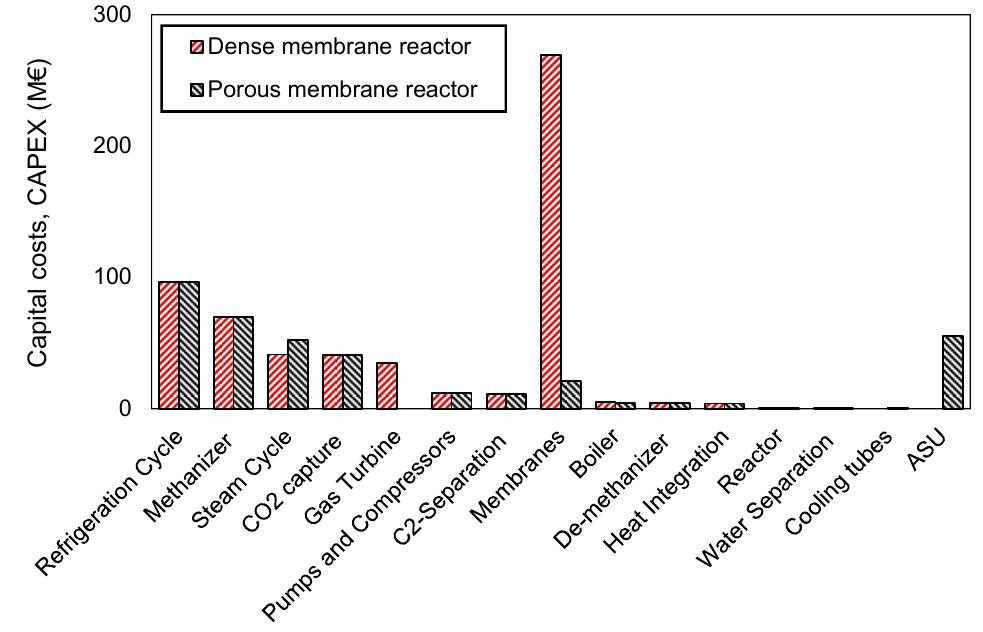
Figure 4. Disaggregated capital costs (BEC), CAPEX (Capital costs), for the OCM plant employing a dense membrane reactor (red) and a porous membrane reactor (black).